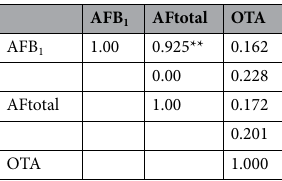
Table 4. Associations of mycotoxins (AFB 1 , AFtotal and OTA) in maize from Upper East Region. **Correlation is significant at the 0.01 level (2-tailed).